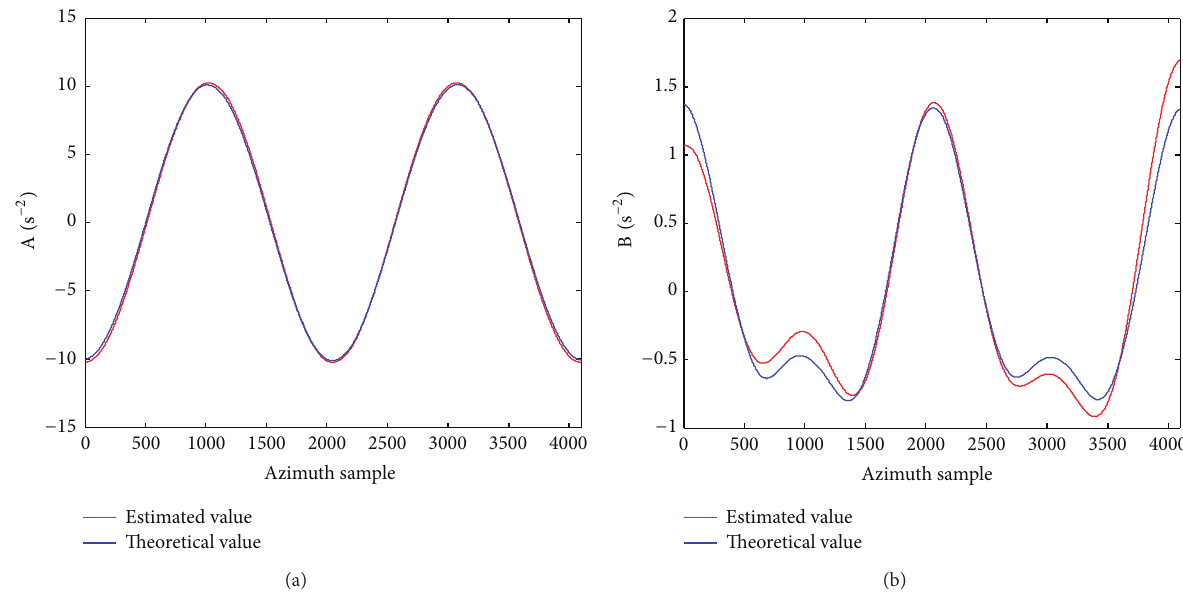
Figure 6: Comparison between the estimated value and the theoretical value of (a) 𝐴 and (b) 𝐵 .